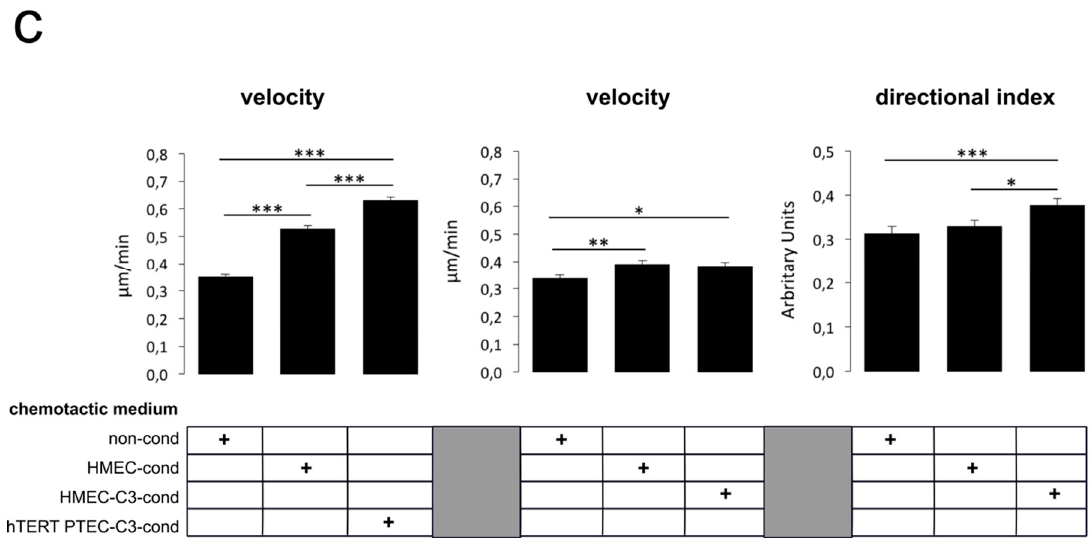
Figure 6. TRPC3 has a role in PCa cell attraction. ( a ) PC3 cells were used to study the e ff ect of TRPA1, TRPV2 and TRPC3 on cancer cell attraction. Control HMEC, channel-overexpressing HMEC or hTERT PTEC were plated in multiwell plates, and PC3 cells were plated in the upper chamber of 8 µ m-pore culture inserts. hTERT PTEC or TRPC3-overexpressing HMEC (HMEC C3) increased PC3 cells migration through the membrane, quantified 24 h after plating. Each dot indicates the cell number in a single field normalized to PC3 cell count; results are presented as normalized values against co-cultured HMEC, while the continuous line represents the median value of normalized cells / field for each condition ( n = 10). The graph shows one representative experiment out of three. Statistical significance: ** p -value < 0.005; *** p -value < 0.0005. Right panel shows the schematic representation of the migration assays used to study PC3 cell migration in co-culture with either hTERT PTEC, TRPA1 / V2 / C3-overexpressing HMEC, or control HMEC. ( b ) Chemotaxis chambers were used to study hTERT PTEC-directed migration in the presence of hTERT PTEC-, TRPC3- overexpressing HMEC-, HMEC- or non-conditioned (non-cond) media. Compared to HMEC conditioned medium, PTEC conditioned medium (24-h conditioning) increased PC3 cell speed ( c , left panel), while compared to control HMEC conditioned medium, the conditioned medium from TRPC3-overexpressing HMECs significantly promoted PC3 migration via directional persistence index and not on the speed ( c , central and right panels). Statistical significance: * p -value < 0.05, ** p - value < 0.005 and *** p -value < 0.0005.